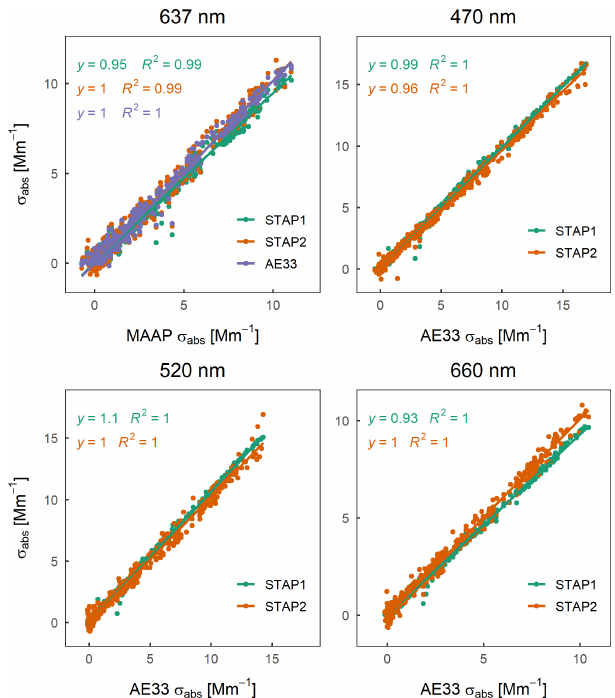
Figure 5. STAP measurements of particle light absorption coef- ficient σ abs (λ) of ambient urban aerosols variably diluted with particle-free air compared with MAAP and AE33.